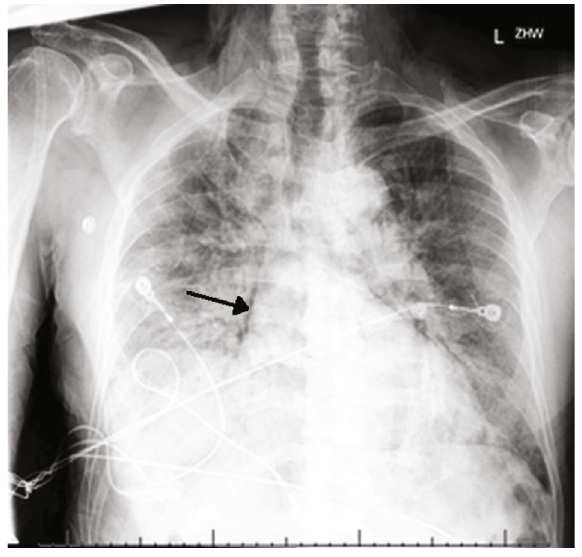
Figure 3: Chest X-ray AP portable with right more than left in fi ltrates, blunting of right costophrenic angle, and pneumomediastinum noted on right border of heart